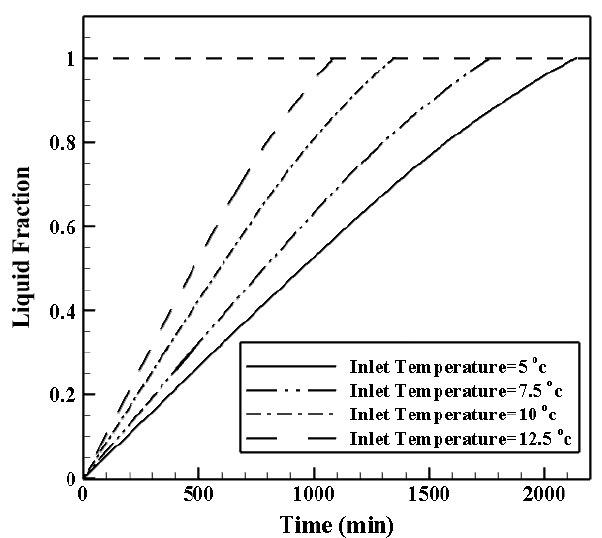
Figure 8. Temporal evolution of the liquid fraction for four different HTF (heat transfer fluid) inlet temperatures of ethylene glycol.